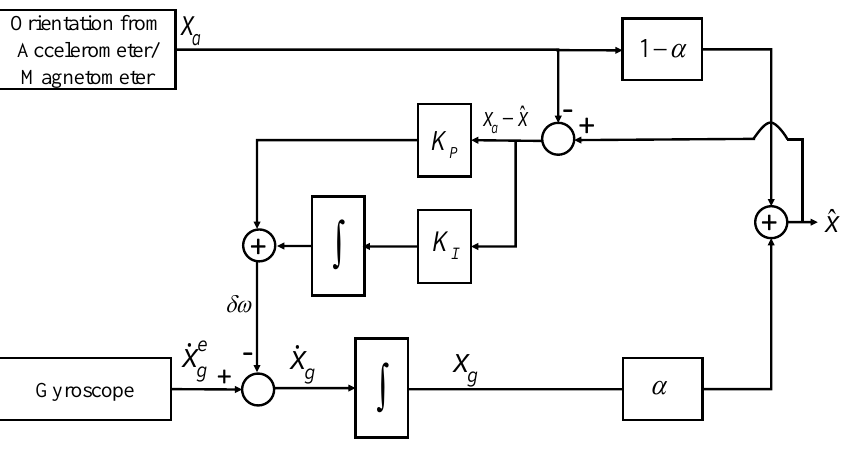
Figure 6. Cascaded Complementary